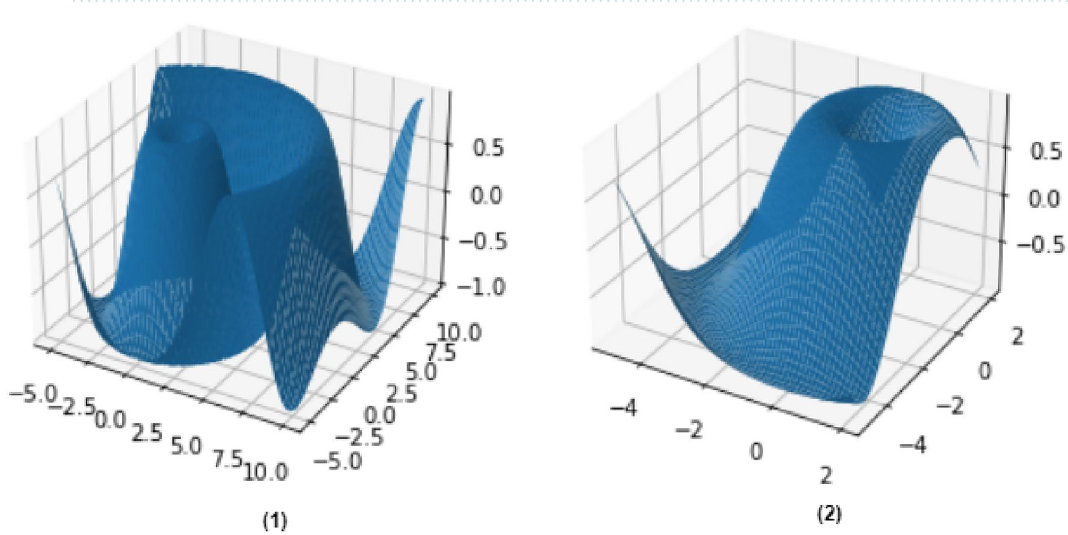
Figure 3. The simulation results of the proposed B-SMEs consensus for lightweight authentication, ( 1 ) shows the fluctuation of previous predefined consensus (PoW), and ( 2 ) shows the difference of adoptation of B-SMEs consensus (PoW and PoS).